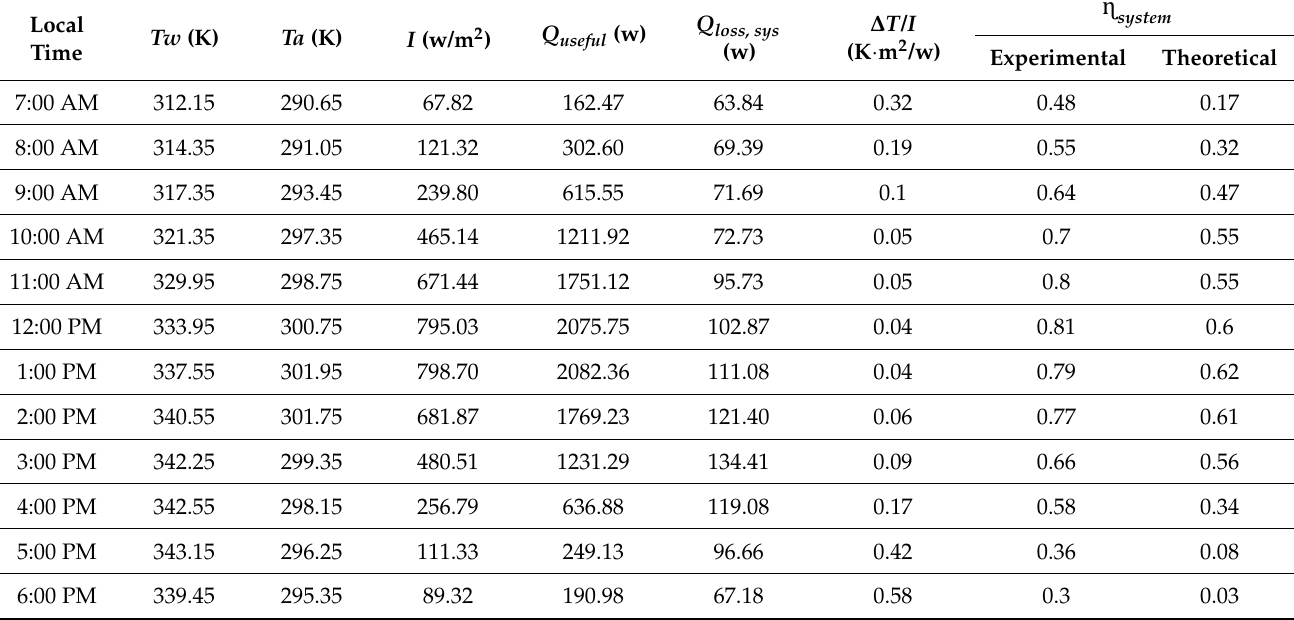
Table 4. Experimental and calculated results for March 2022 with paraffin. Table 5. Experimental and calculated results for June 2022 with